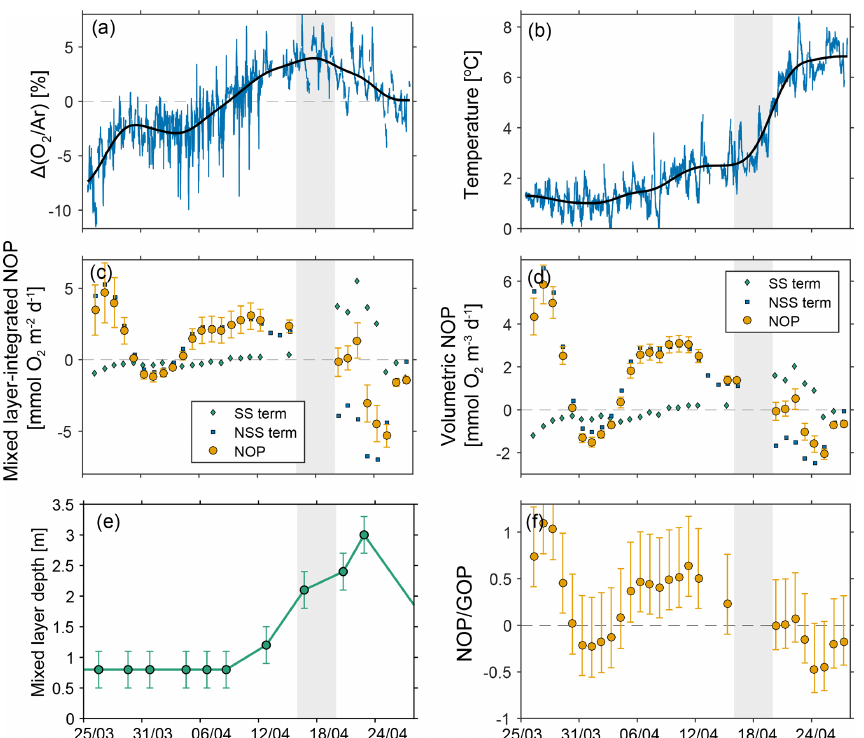
Figure 7. Net oxygen production at Little Narrows. Net oxygen production at Little Narrows and data used in the calculation. (a) (cid:49) (O 2 / Ar) and (b) temperature measurements. The blue lines are the raw data and the black line is the filtered data. NOP in (c) mixed layer-integrated and (d) volumetric units. The green diamonds and blue squares show the values of the two terms in the GOP calculation (steady state, SS, and non-steady state, NSS). (e) Mixed layer depth. (f) Export efficiency ratio (NOP / GOP). The shaded grey area is the period where we do not calculate NOP due to uncertainties related to the rapidly melting ice